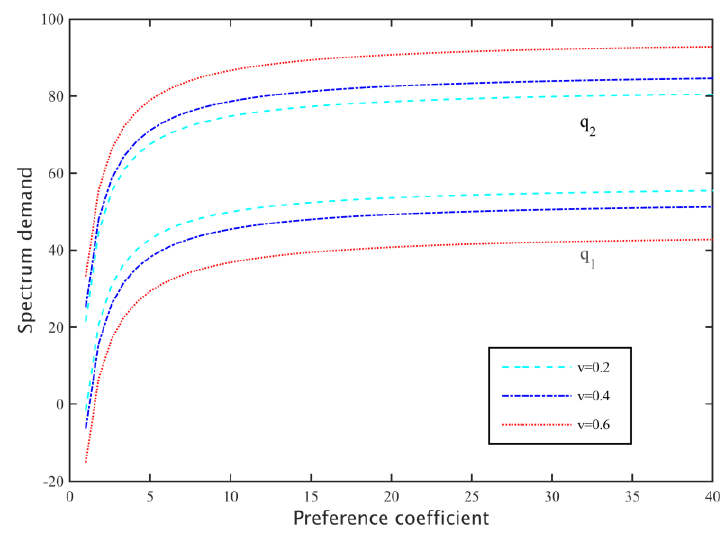
Figure 6. Influence of preference coefficient on spectrum demand.